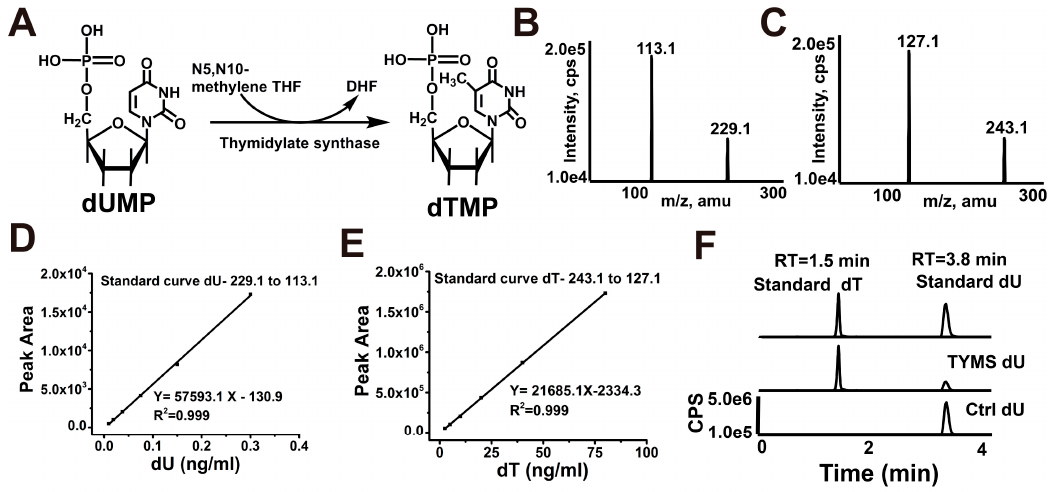
Figure 1. HPLC–MS/MS assay measures the reductive methylation activity of thymidylate synthase (TYMS) in vitro. ( A ) Deoxyuridine monophosphate (dUMP) and 5,10-methylenetetrahydrofolate (mTHF) as cosubstrates generate deoxythymidine monophosphate (dTMP) by TYMS, yielding 7,8-dihydrofolate (DHF) as a secondary product; ( B , C ) Base ion mass transitions for LC–MS-MS analysis of dU and dT standard. The multiple reaction monitoring (MRM) transitions were monitored as follows: 229.1 to 113.1 (dU); 243.1 to 127.1 (dT); ( D , E ) HPLC–MS-MS standards curves of dU and dT (F) LC–MS-MS profiles of nucleosides derived from TYMS treatment. The upper LC–MS-MS profile shows nucleoside dU and dT standards. The lower LC–MS-MS profile shows dT generation in vitro reaction system of TYMS with dU as